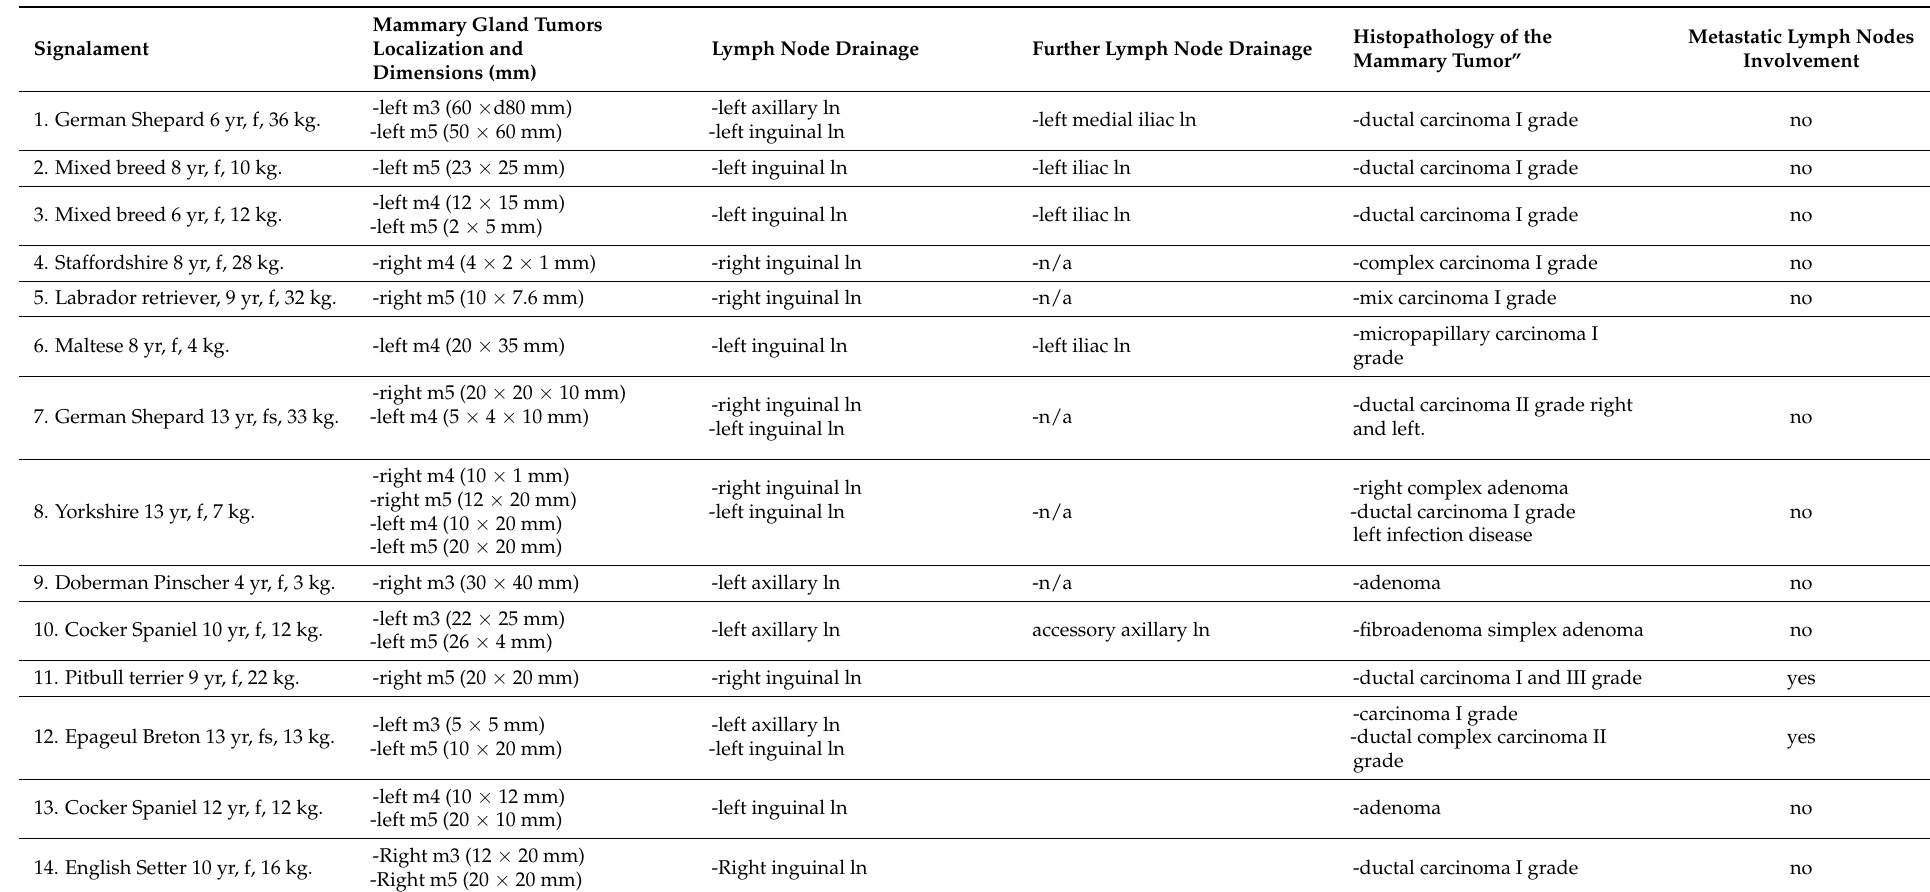
Table 1. Signalament; mammary tumor and lymph drainage; diagnosis and metastatic have been reported; yr: year old; f: entire female; fs: spayed female; ln: lymph node; m: mammary